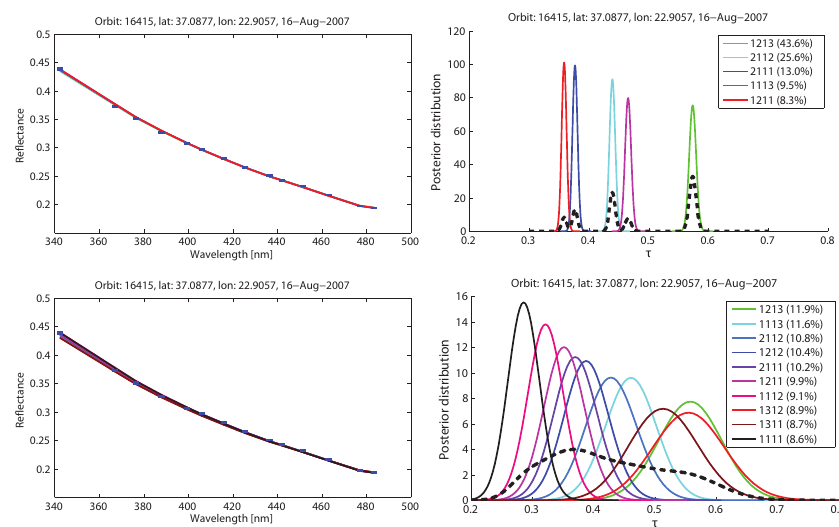
Fig. 5. Greece, 16 August 2007. Upper row: the best five models when model discrepancy is not included. Bottom row: the best ten models when model discrepancy is included. Observed and modelled reflectances on the left, and posterior probability distributions for the AOT parameter τ on the right. The reflectance observations are marked by blue dots and error-bars corresponding to 2 × standard error uncertainty. The modelled reflectance curves on the left match the colours of the individual posterior distributions on the right, although overlaying each other. On the right, the dashed black curve is the averaged posterior distribution over the best models that account for at least 80% of the total posterior weights of all the models.